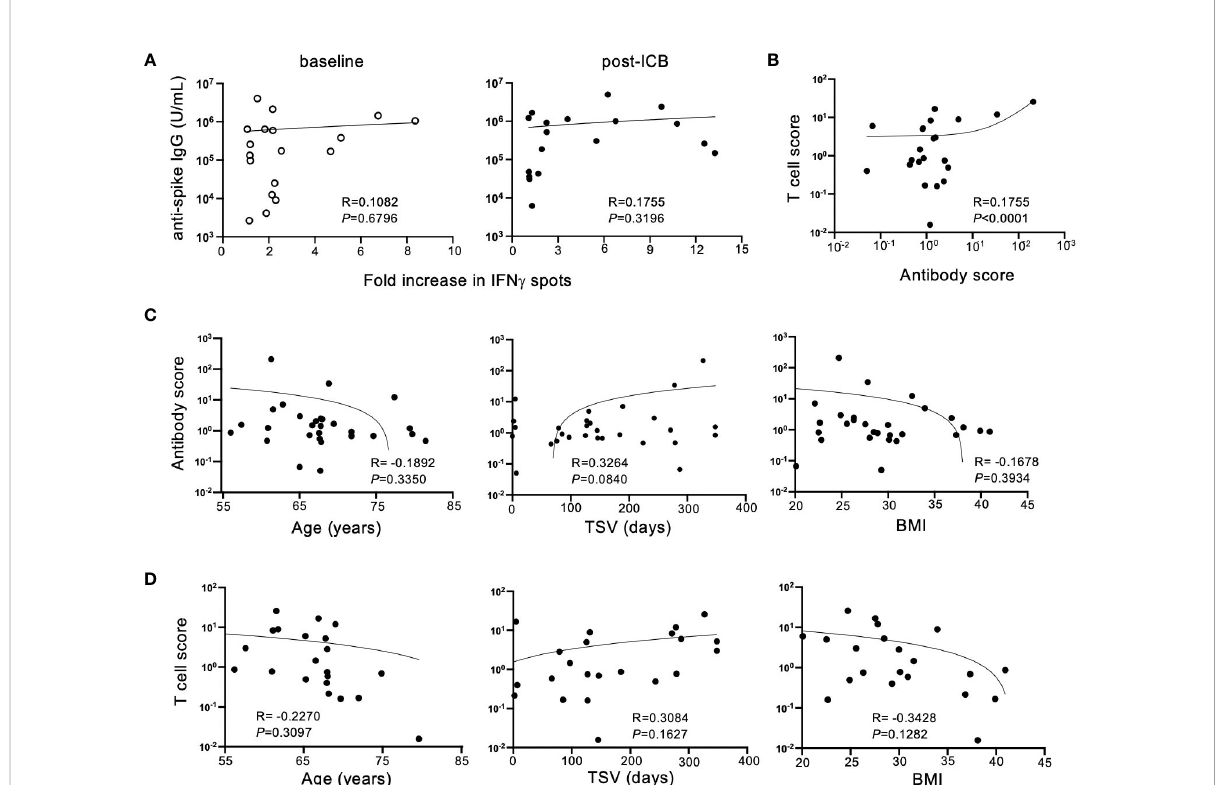
FIGURE 3 Humoral and cellular immune responses to SARS-CoV-2 SP after ICB correlate in a patient-speci fi c, but not generalizable, manner. (A) Correlation between SARS-CoV-2 spike protein antibody titers and T cell responses at baseline (prior to ICB) and following two rounds of ICB infusion. (B) Antibody and T cell scores were generated for the vaccinated patient cohort by dividing the post-ICB value (titer or T cell activity) by the baseline value, respectively. Correlations between antibody score and T cell score in the vaccinated patient cohort were determined. (C) Correlation between antibody score of vaccinated patients (n=29) and age, time since vaccination (TSV), and BMI. (D) Correlation between T cell score of vaccinated patients (n=22) and age, time since vaccination, and BMI. Each point represents data from an individual patient and inset numbers indicate the r values for each dataset along with corresponding P